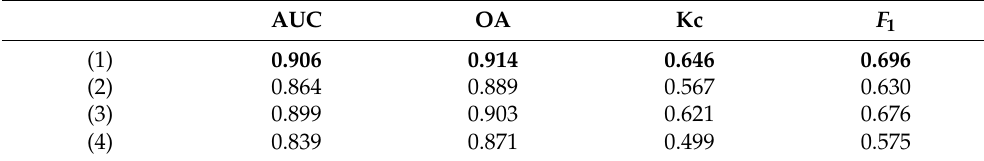
Table 6. Ablation study on the Toulouse dataset.